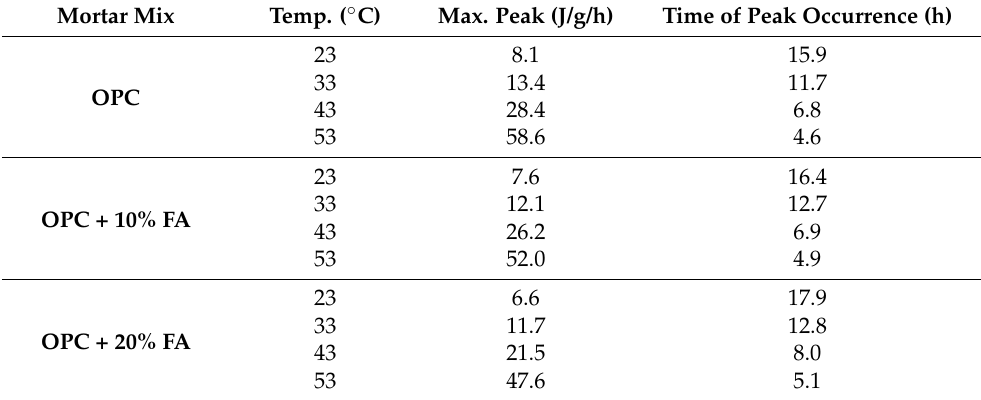
Table 4. Maximum peak value of heat generation rate.